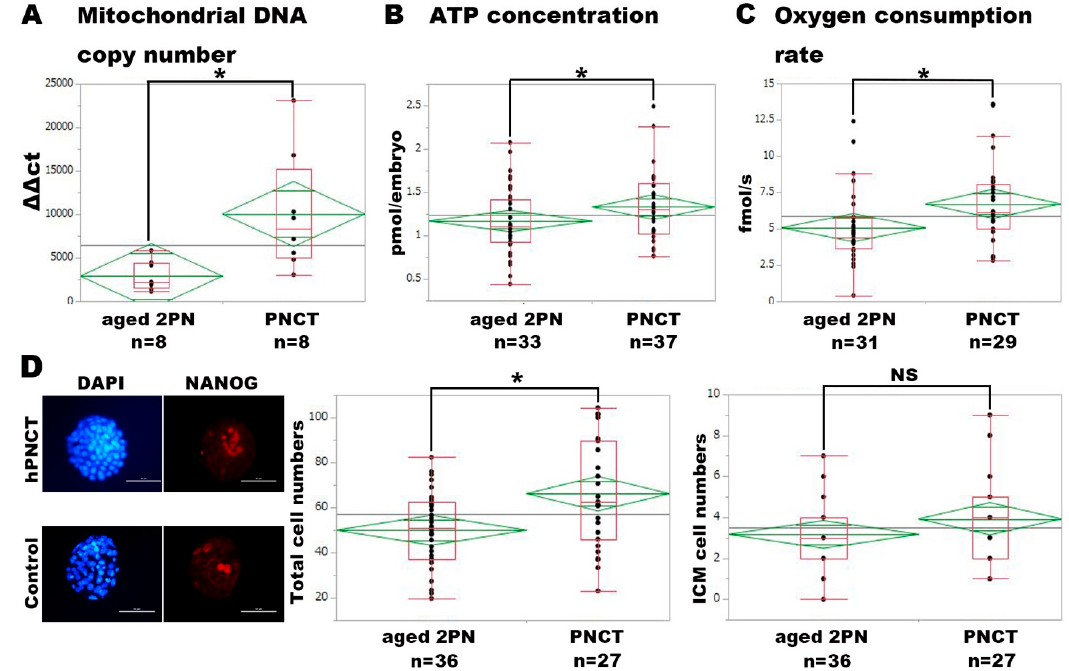
Figure 3. Analyses of mitochondrial DNA copy number, ATP content, oxygen consumption rate, and cell counting for PNCT embryos. ( A ) Figure depicts the relative quantification of mitochondrial DNA copies. PNCT embryos were harvested at the 2-cell stage for both groups. ( B ) ATP concentration of blastocyst-stage embryos is shown. ( C ) Oxygen consumption rate measured by CERMs in the blastocyst-stage embryos is shown. ( D ) Left panel depicts immunohistochemistry against NANOG (for ICM) and DAPI (for total cells). ATP, OCR measurement, and cell counting were performed using blastocysts obtained by PNCT with “fresh” 3PN. White bar indicates 100 μ m. Middle panel depicts total cell numbers. Right panel depicts ICM numbers. Asterisk indicates statistical significance ( p < 0.05). NS indicates statistically not significant.